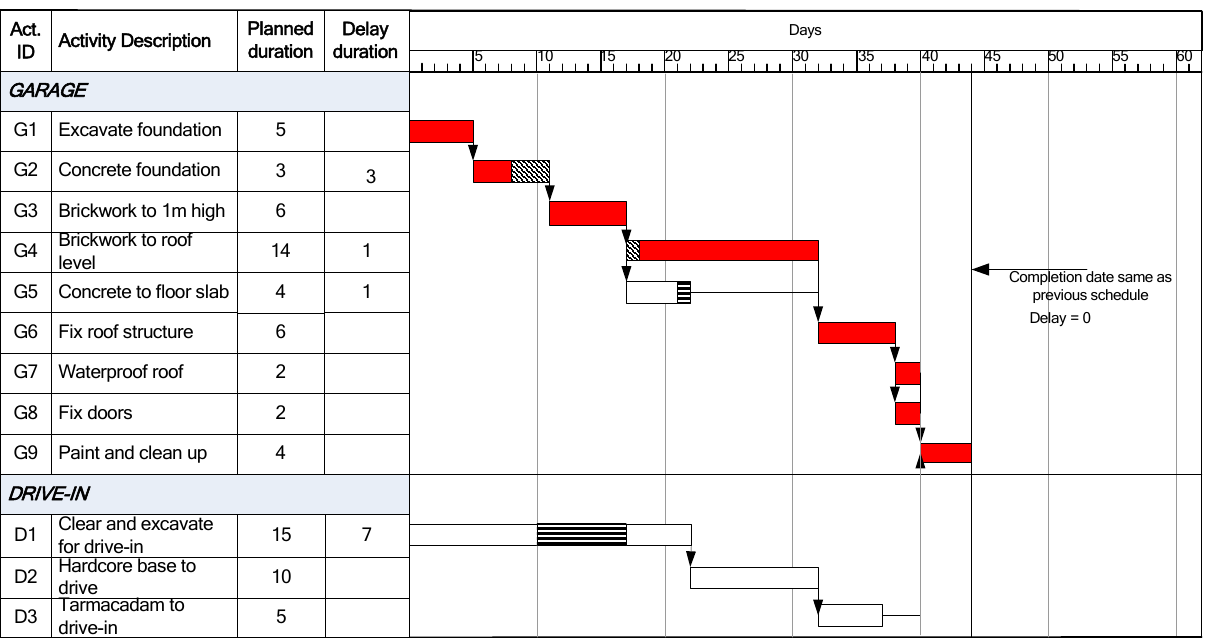
Figure 8. Impact of fourth